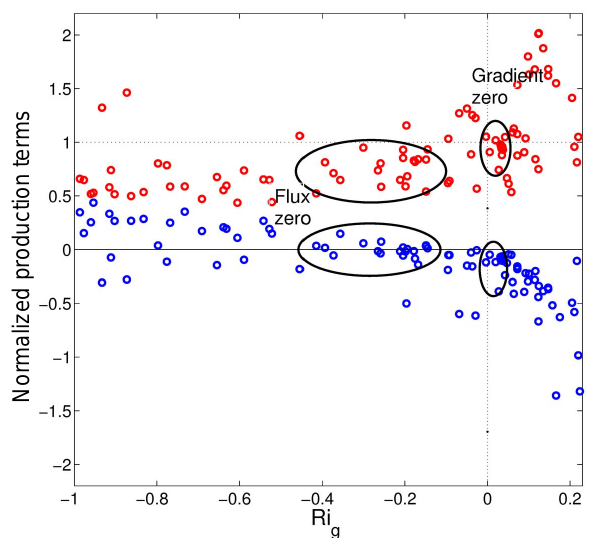
Figure 9. Normalized production terms (buoyancy production = − z/L in blue and shear production in red) for near neutral are shown as a function of Richardson number. Two larger horizon- tal ellipses encircle some data for which the buoyancy flux is very small, but the Richardson number remains in the range of between about − 0.2 and − 0.4, and normalized shear production averages to about 0.7. Two smaller vertical ellipses encircles some data for which both the buoyancy flux is small and Richardson number is small, and normalized shear production averages to about